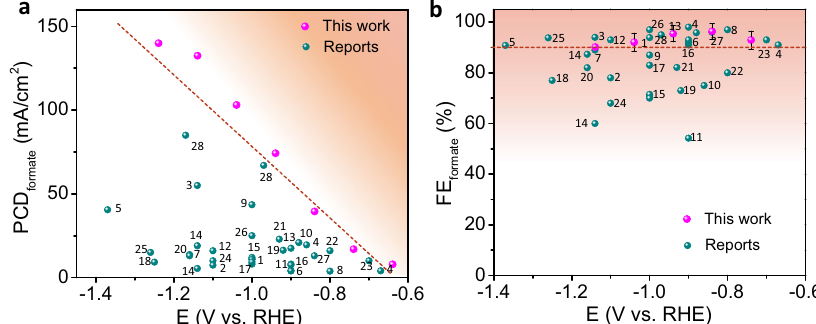
Fig. 6 CO 2 RR performance comparison with the reported data in the literature. a PCD toward formate and b FE for formate. (The inserted reference numbers represent the references in Supplementary Table 6 in the Supplementary